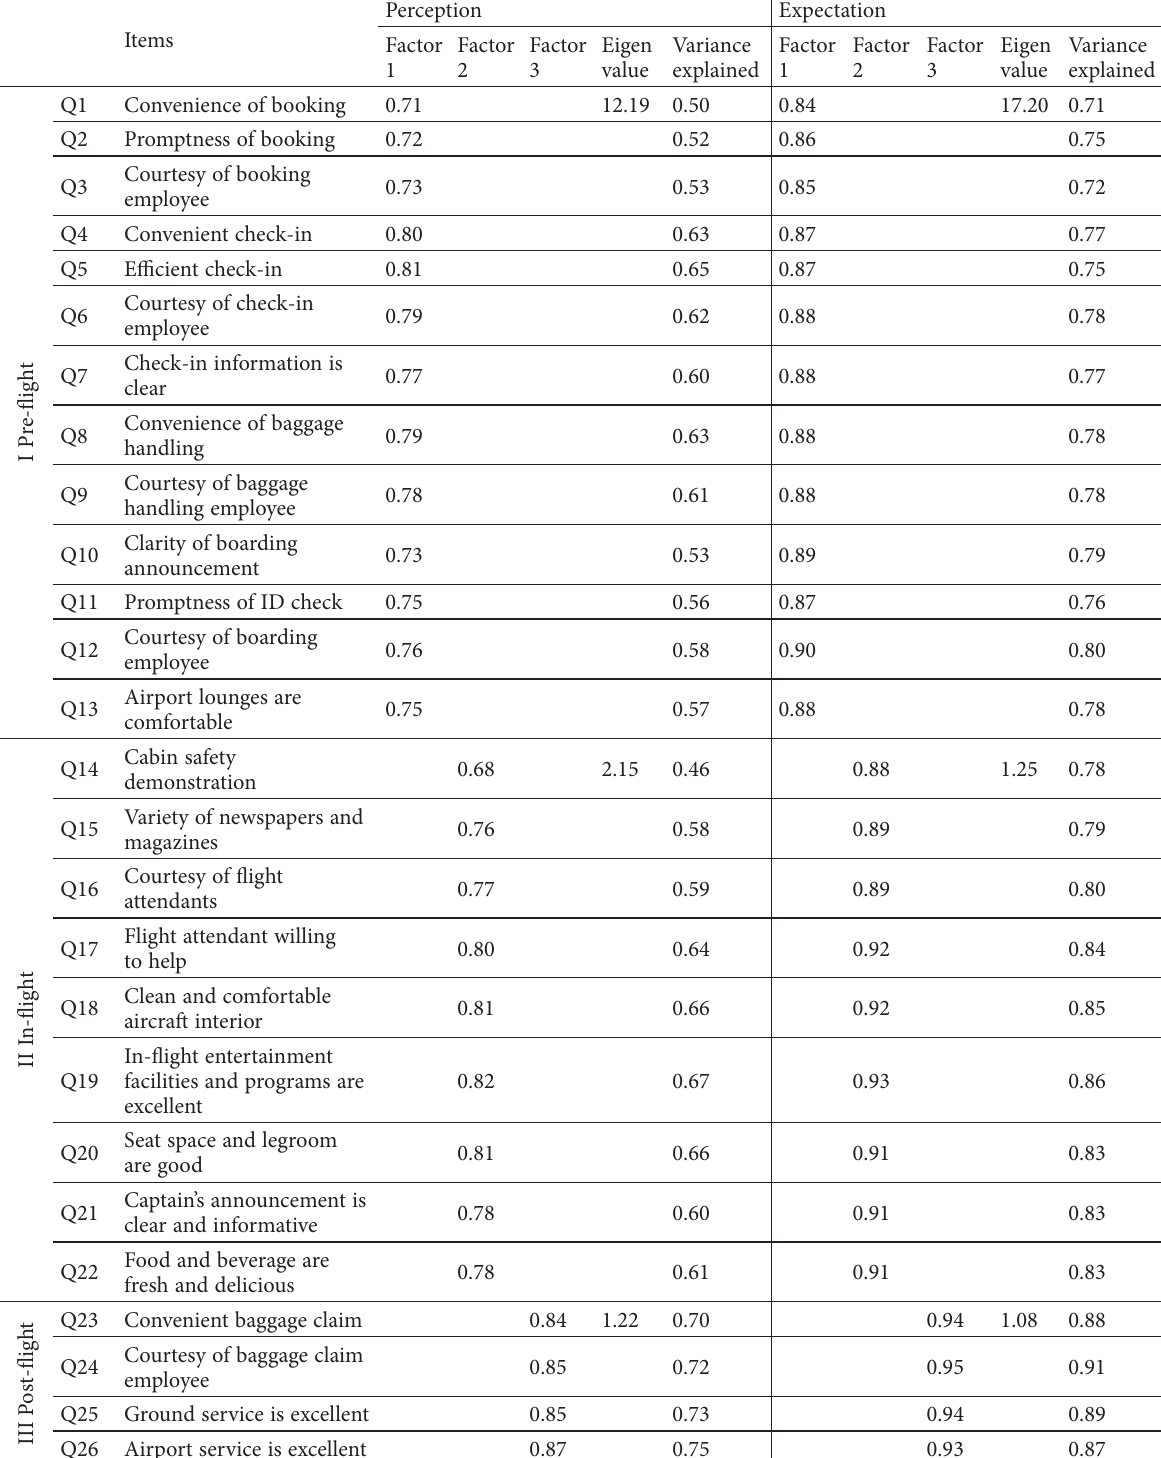
Table 2. Exploratory factor analysis